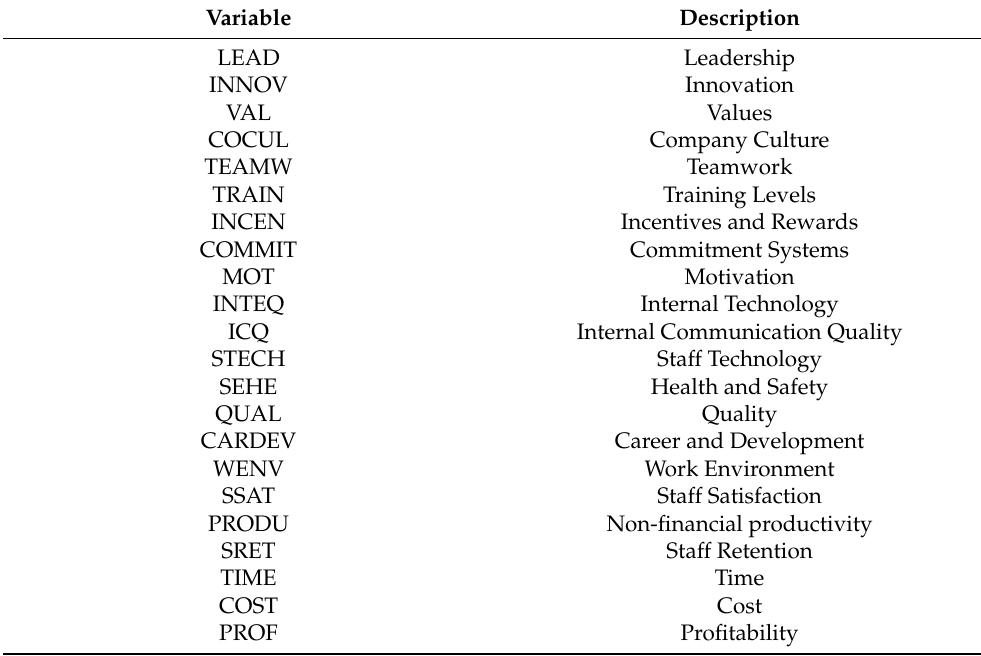
Table 5. Most Relevant Human Resource